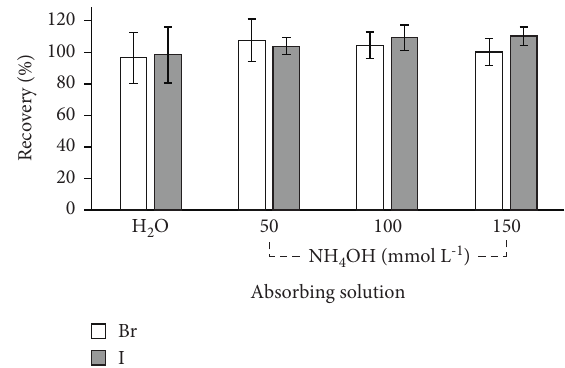
Figure 3: Recoveries obtained by ICP-MS for bromine and iodine in mushrooms digested by MIC after the addition of 75% of bromine concentration and 2 times the LOQ for iodine ( n �